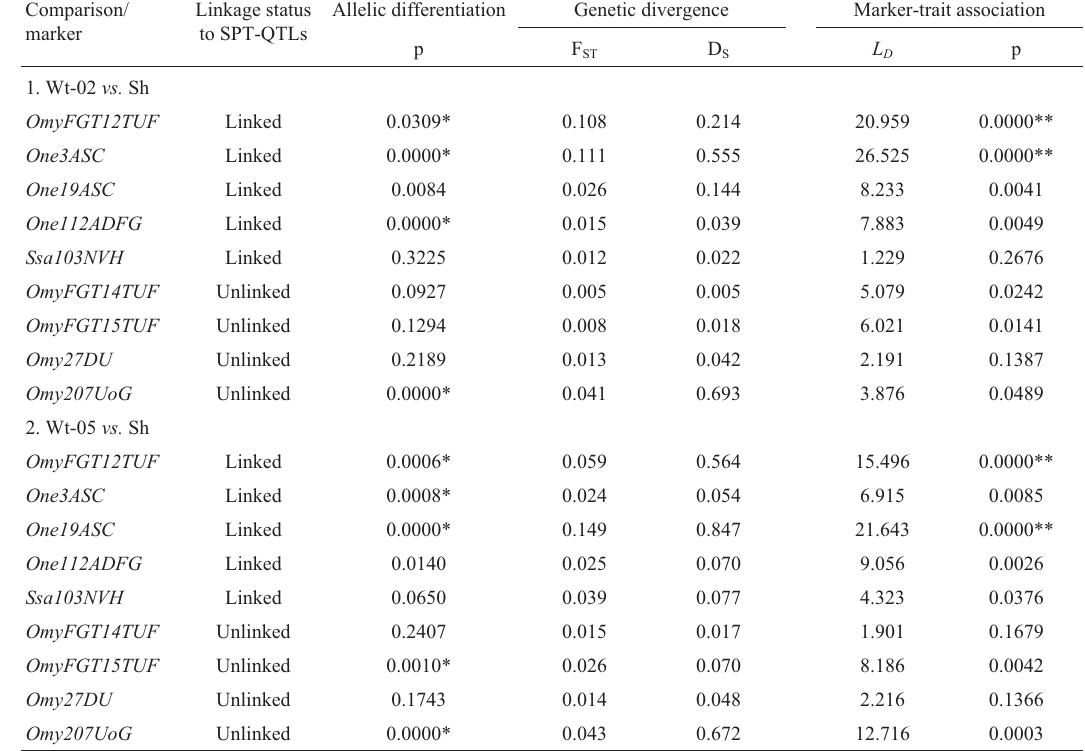
Table 2 - Association analysis between spawning time QTL markers and the double annual reproductive cycle trait in rainbow trout. Comparison/